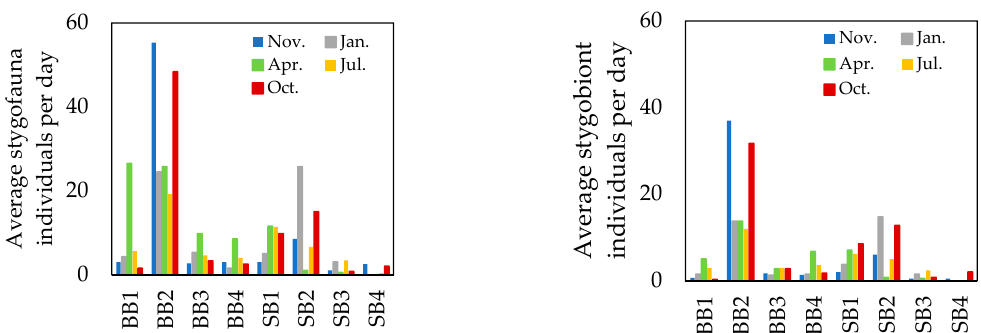
Figure 5. Average number of individuals of stygofauna (invertebrates) ( left ) and stygobites ( right ) per day for each sampled spring and sampling campaign.